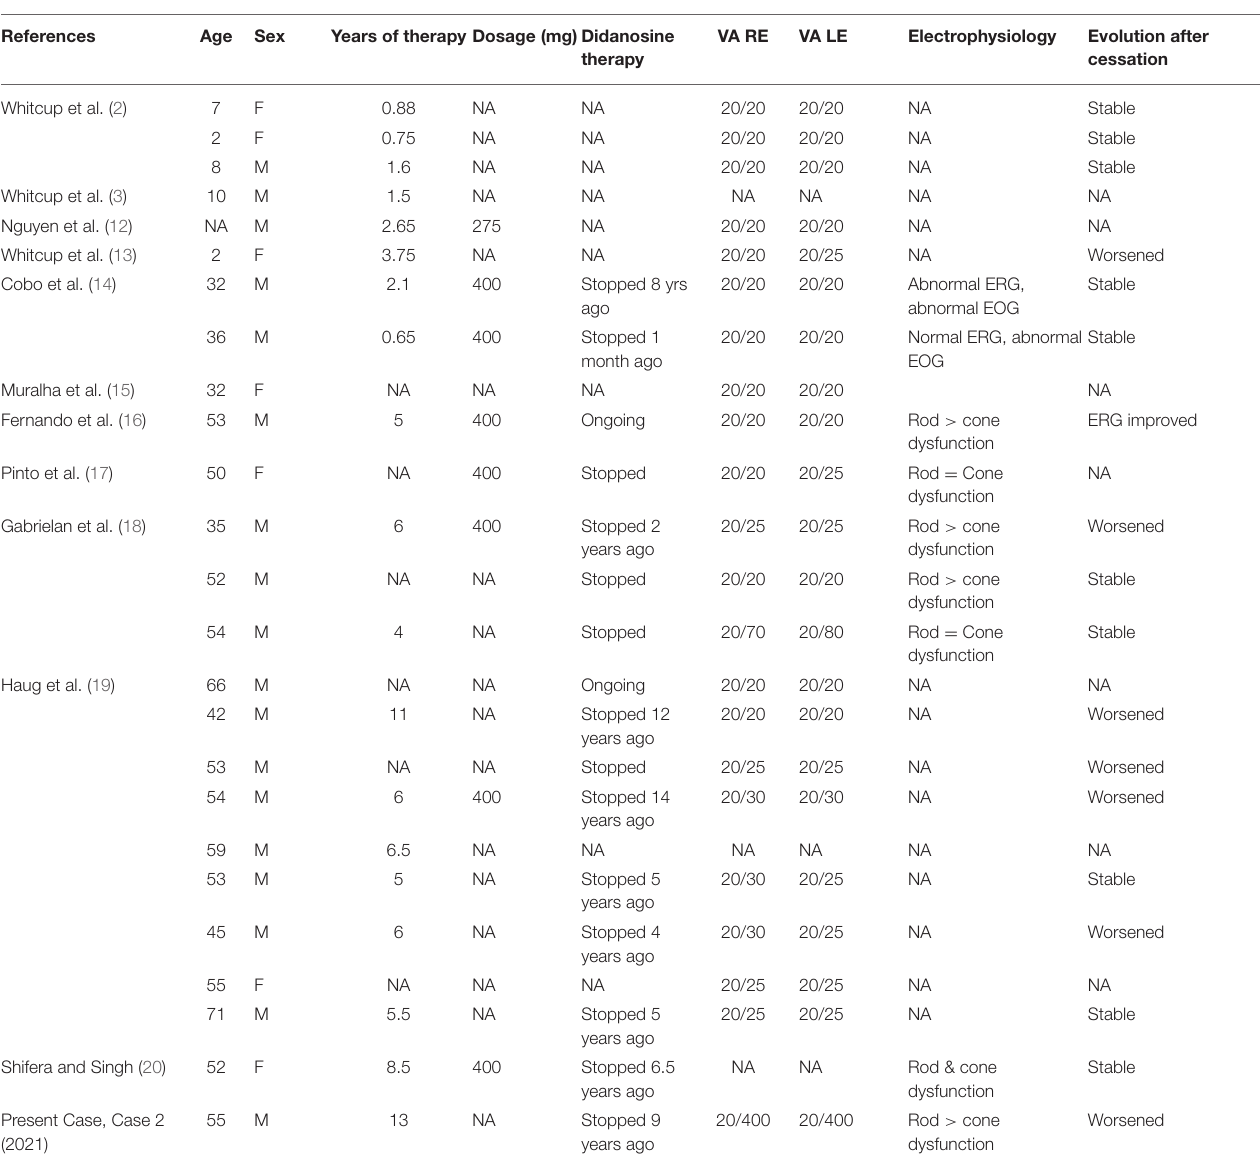
TABLE 2 | Didanosine peripheral retinopathy literature